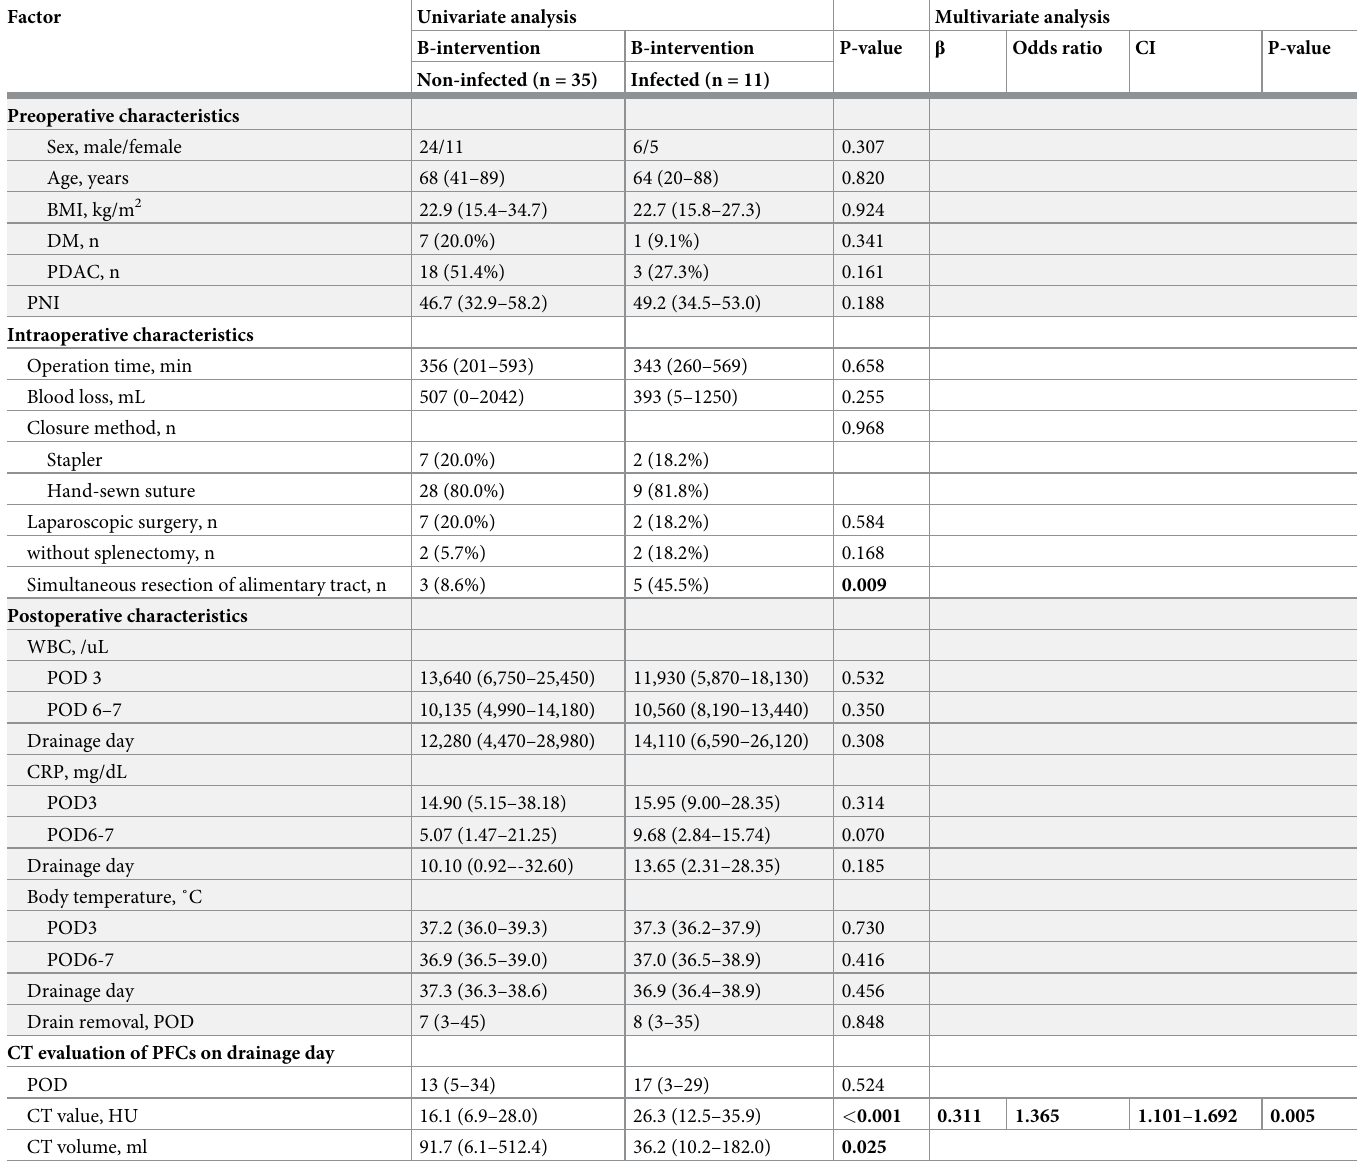
Table 4. Predictive factors for peripancreatic fluid infection after distal pancreatectomy.